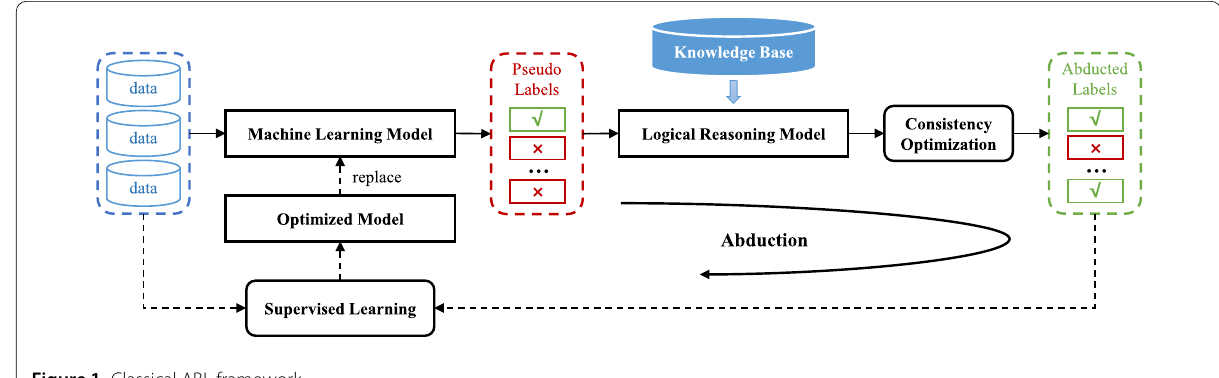
Figure 1 Classical ABL